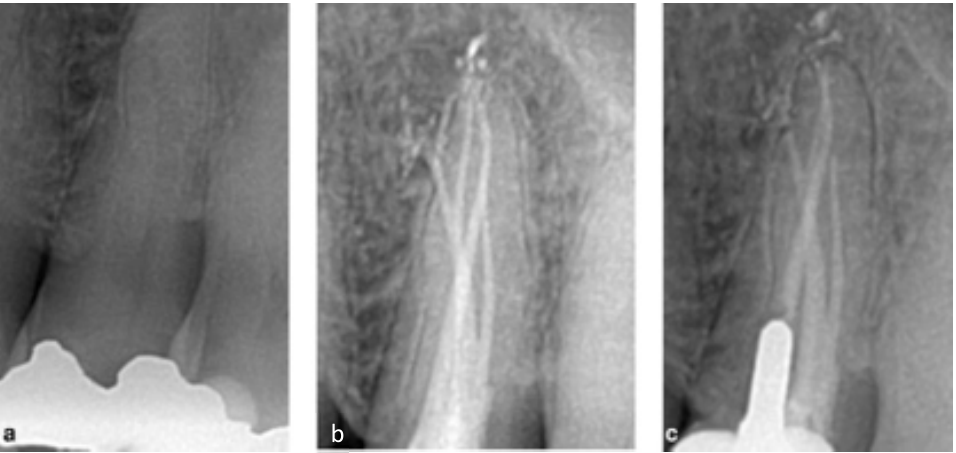
Figure 5. ( a ) Pre ‐ operative view of the premolar, ( b ) post ‐ operative X ‐ ray of the four canals filled with gutta ‐ percha, ( c ) 1 ‐ year follow ‐